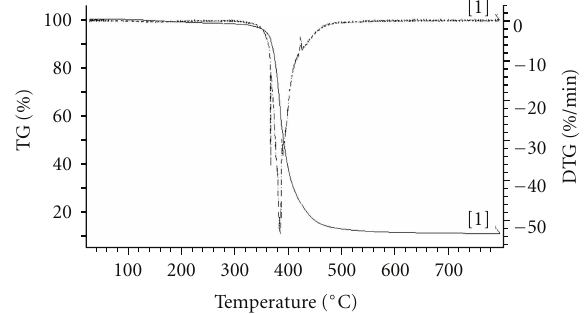
Figure 5: TG and DTG of epoxy clay nanocomposite prepared by mechanical stirring and ultrasonic treatment of 3-hour duration.